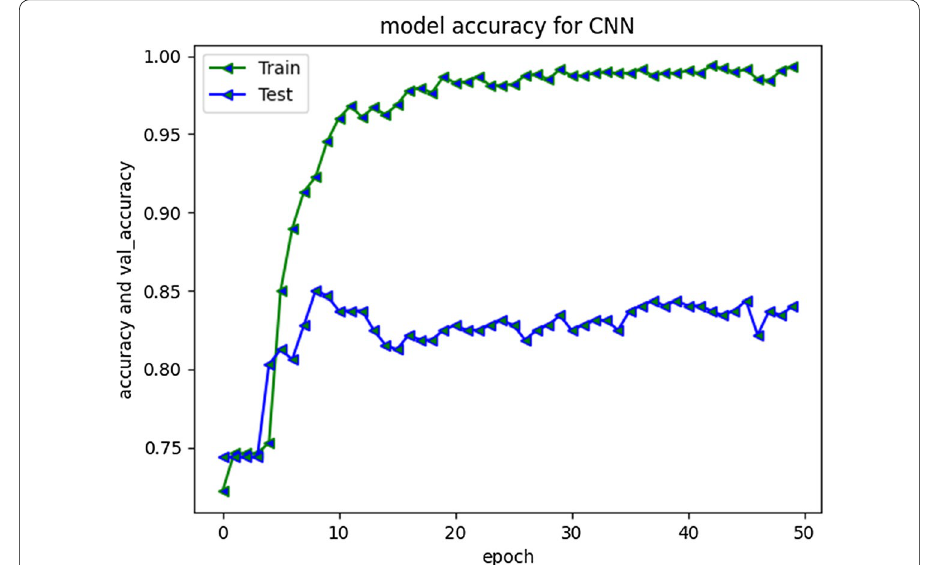
Fig. 16 CNN Model accuracy plot for 50 epochs